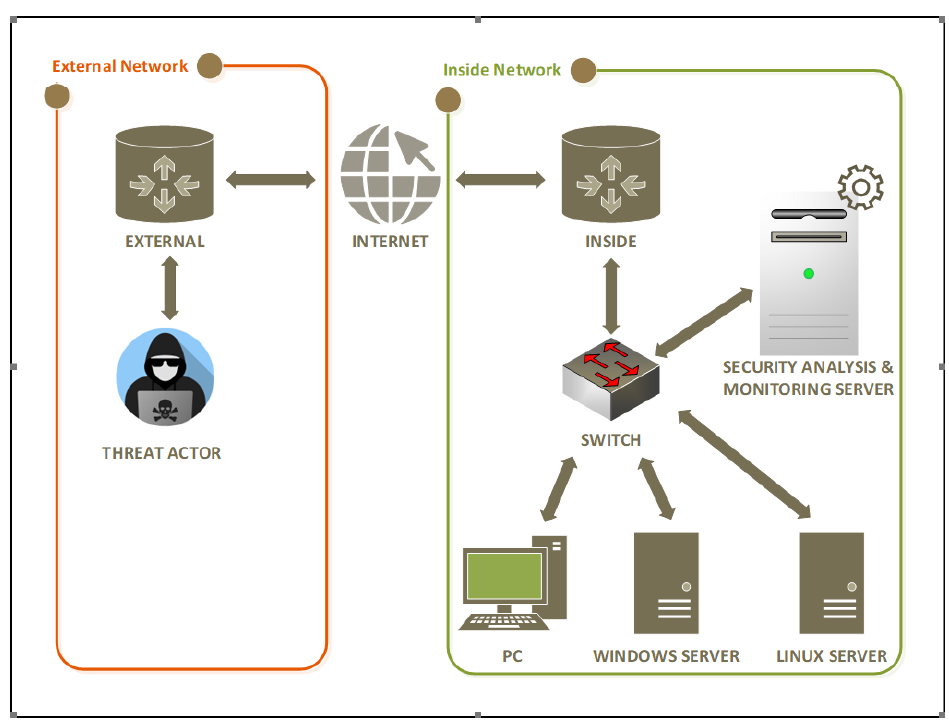
Figure 3. The virtualised components interaction model.